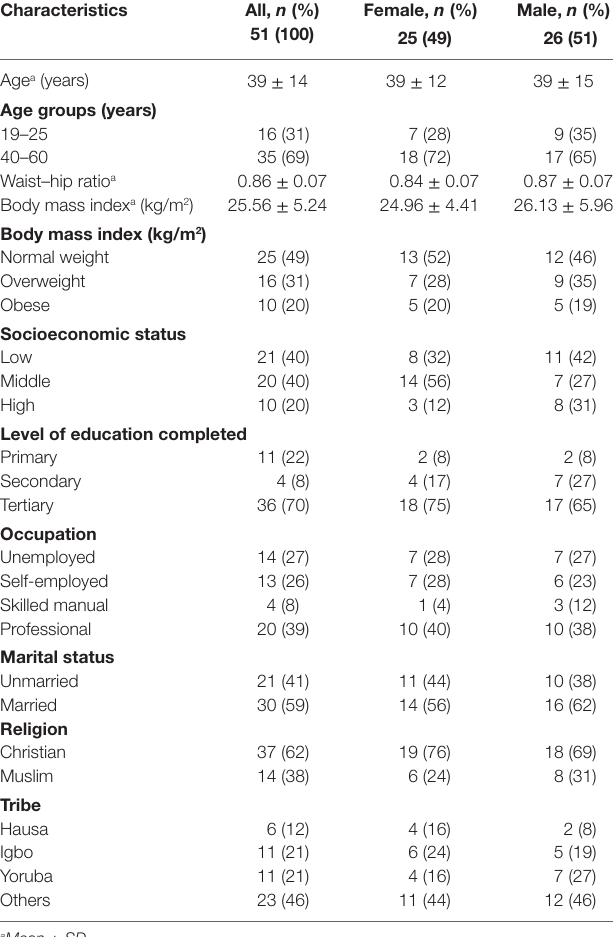
TaBle 1 | Baseline characteristics of the study participants. characteristics